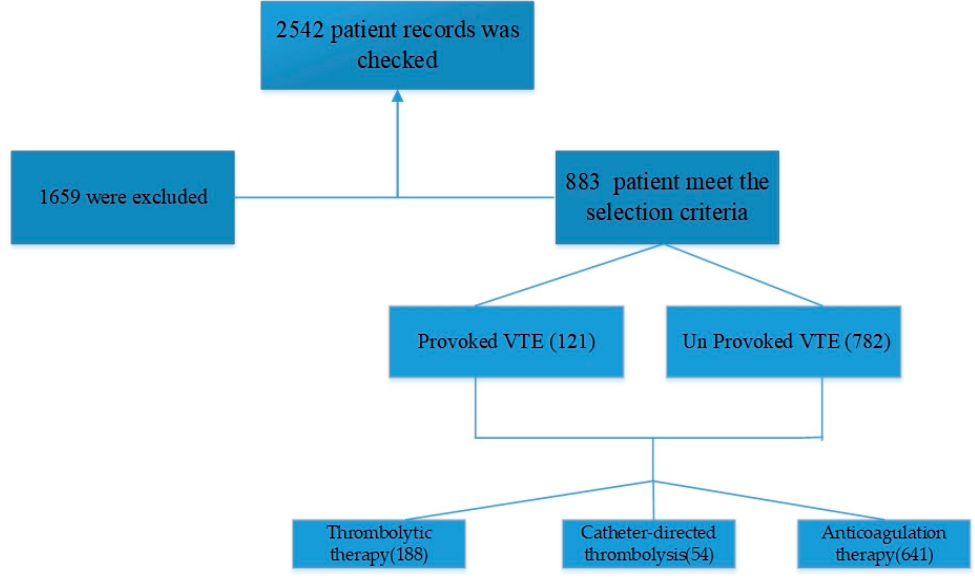
Figure 1. The fl ow chart of patient selections. Figure 1. The flow chart of patient selections. Table 1. Cases of provoked versus unprovoked VTE .